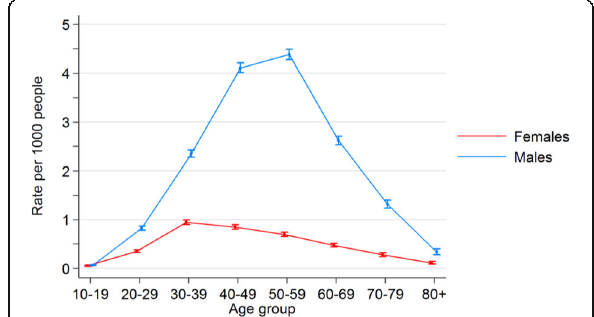
Fig. 1 Rate of anti-HIV medication use in the 2015 Australian resident population